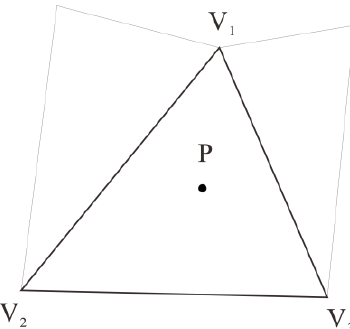
Figure 3. The schematic diagram of the linear interpolation method based on